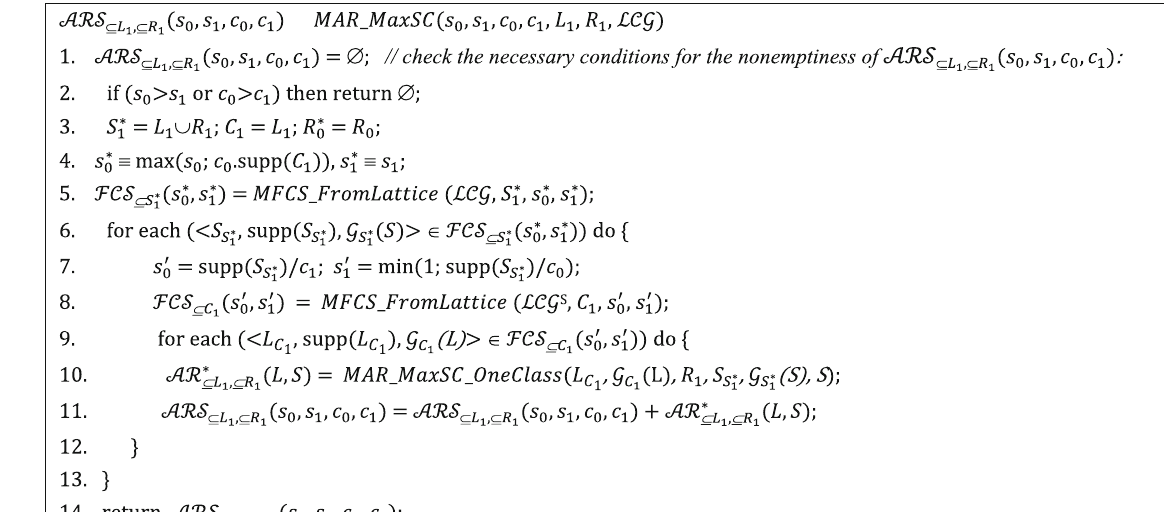
Fig. 5 The M AR _ MaxSC algorithm